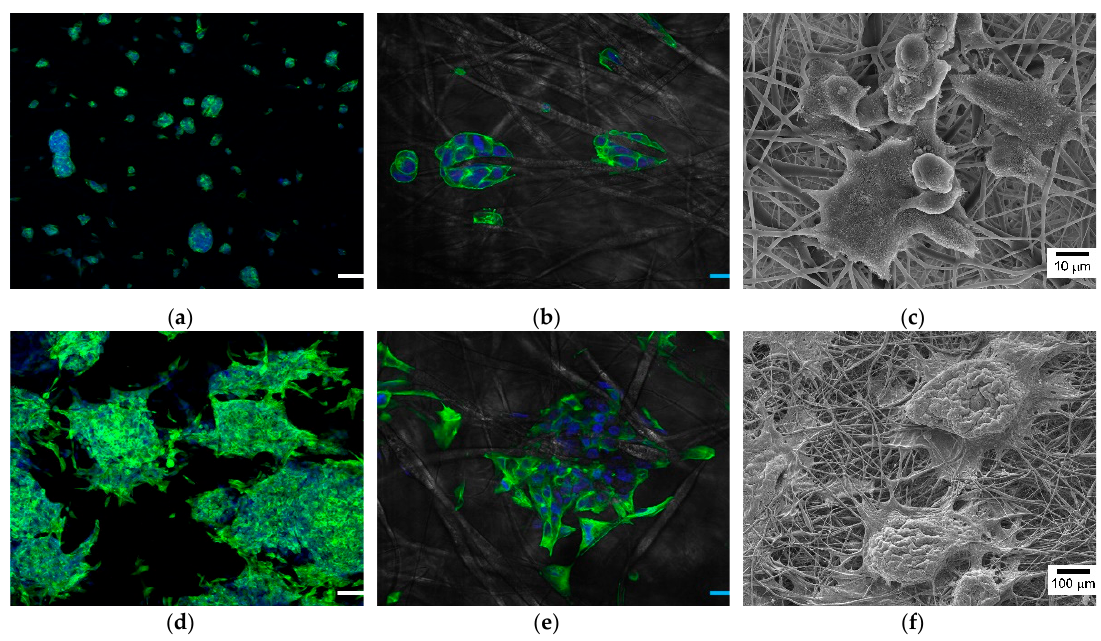
Figure 7. Confocal microscopy and SEM images of the cells cultured on the nanofiber chamber with microfluidic system for 1 ( a , b , e ) and 14 days ( c , d , f ). Especially, ( b , e ) are enlarged images of ( a , d ). The scale bars in the confocal microscopy images are 100 μ m ( a , d ) and 20 μ m ( b , e ).